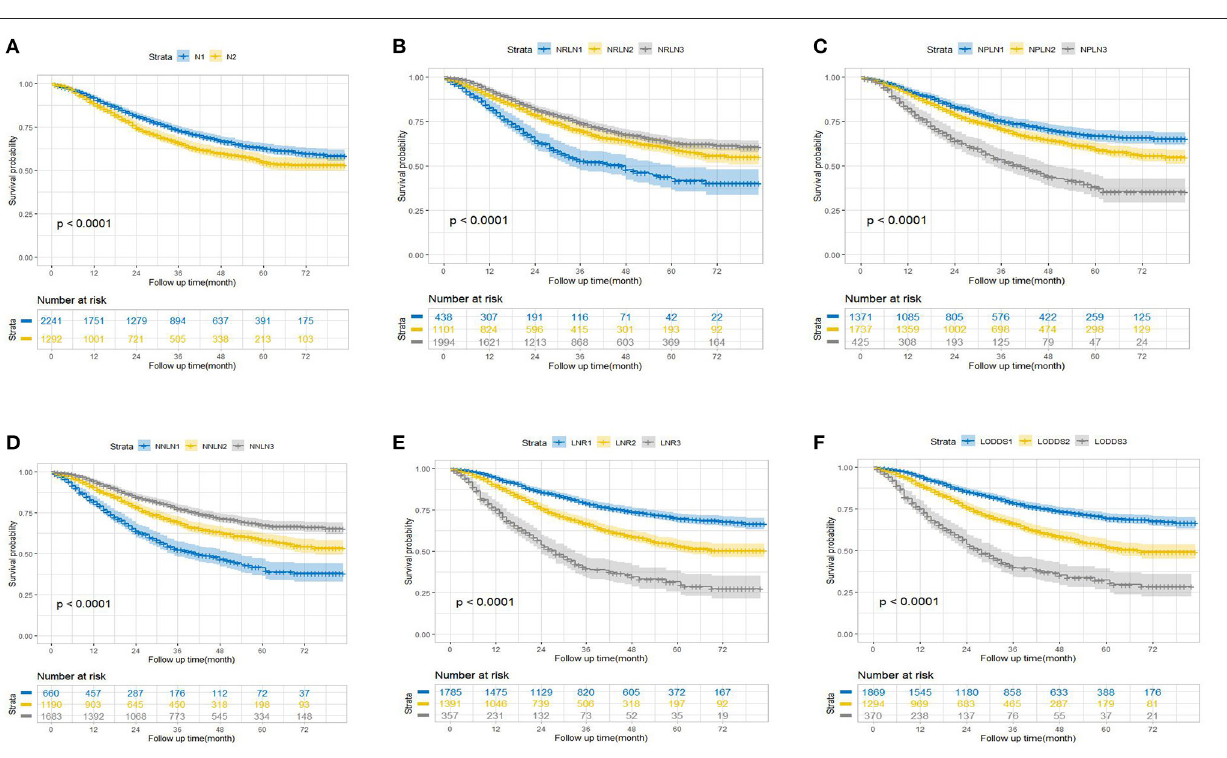
FIGURE 1 | Kaplan–Meier estimates of overall survival according to (A) N, (B) NRLN, (C) NPLN, (D) NNLN, (E) LNR, and (F) LODDS staging systems. NRLN, number of retrieved lymph nodes; NPLN, number of positive lymph nodes; NNLN, number of negative lymph nodes; LNR, lymph node ratio; LODDS, log odds of positive lymph